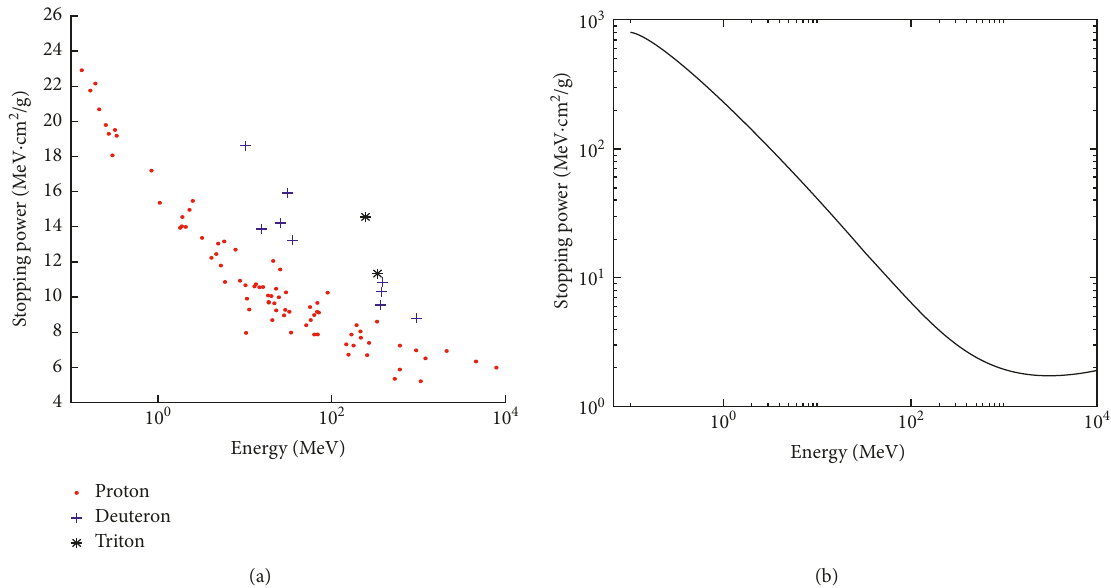
Figure 7: (a) Kinetic energy versus first diamond energy stopping power for 400AMeV iron beam and 20 g/cm 2 upstream polyethylene target thickness. (b) Proton stopping power graph for a graphite target